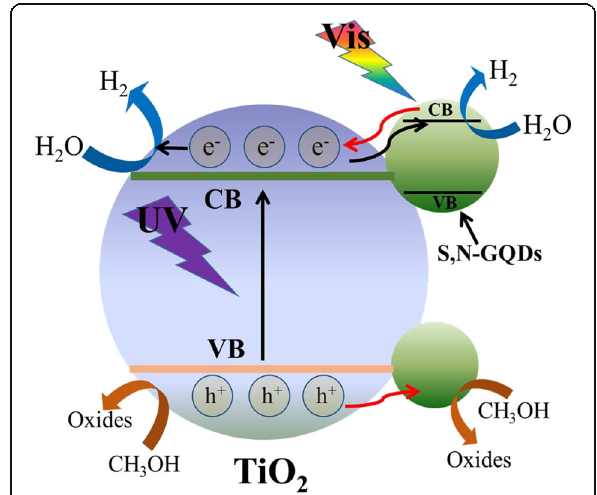
Fig. 11 Proposed mechanism for the photocatalytic H 2 evolution of S,N-GQD/P25 composites under UV-vis light